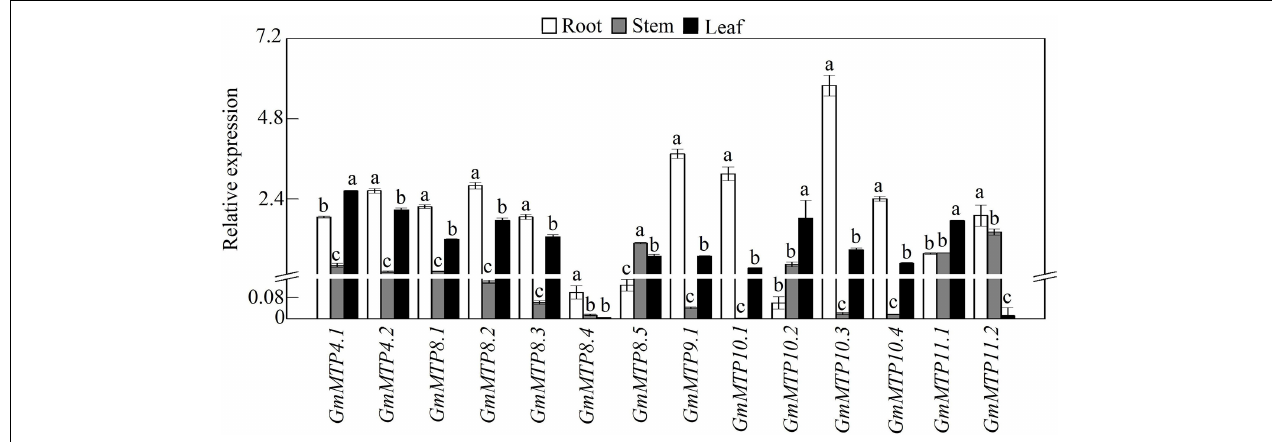
FIGURE 4 | Expressions of GmMTPs in leaf, stem, and root of soybean. After seeds were germinated for 7 days, the seedlings were transplanted into a full-strength Hoagland solution. Leaf, stem, and root were harvested separately after 14 days of growth for gene expression analysis. Each bar represents the mean value of three independent replicates with standard error. White, gray, and black bars represent root, stem, and leaf, respectively. Different lower case letters indicate significant differences at P < 0.05 in the same